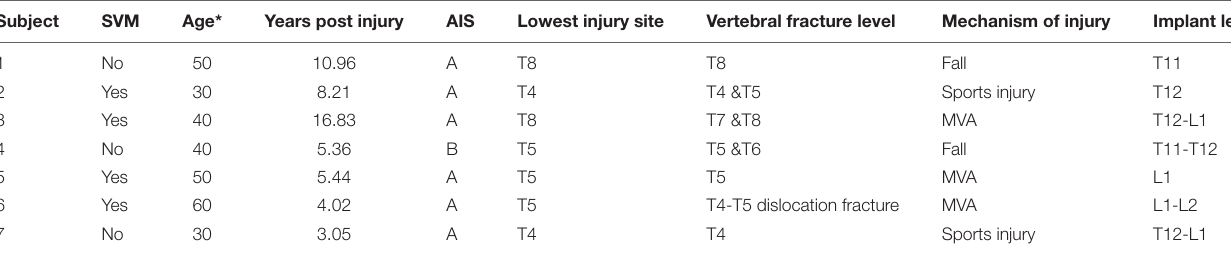
TABLE 1 | Demographic information: *ages are rounded to the closest